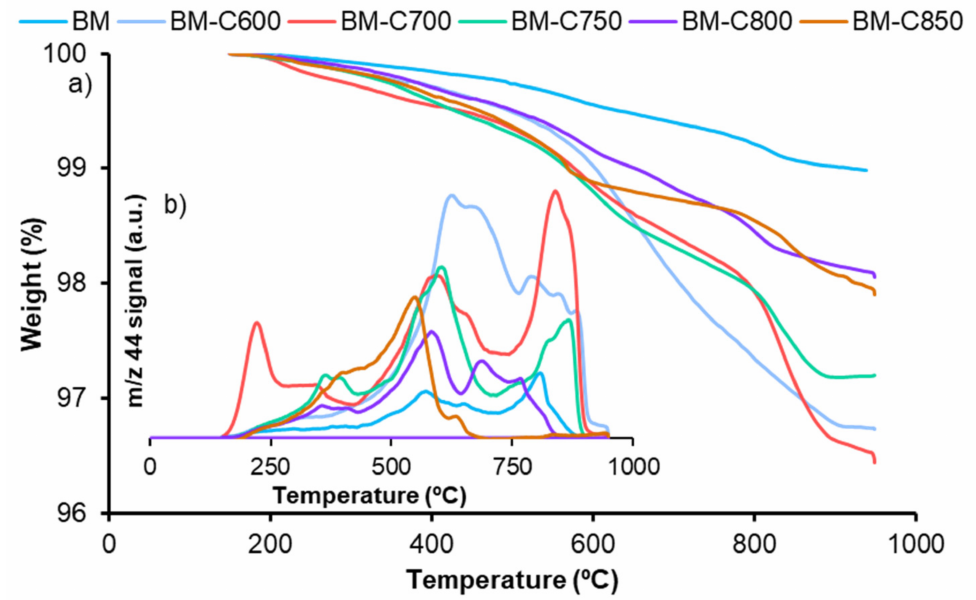
Figure A5. ( a )TGA profiles and ( b ) 44 m/z signal during the analysis of BM-CX